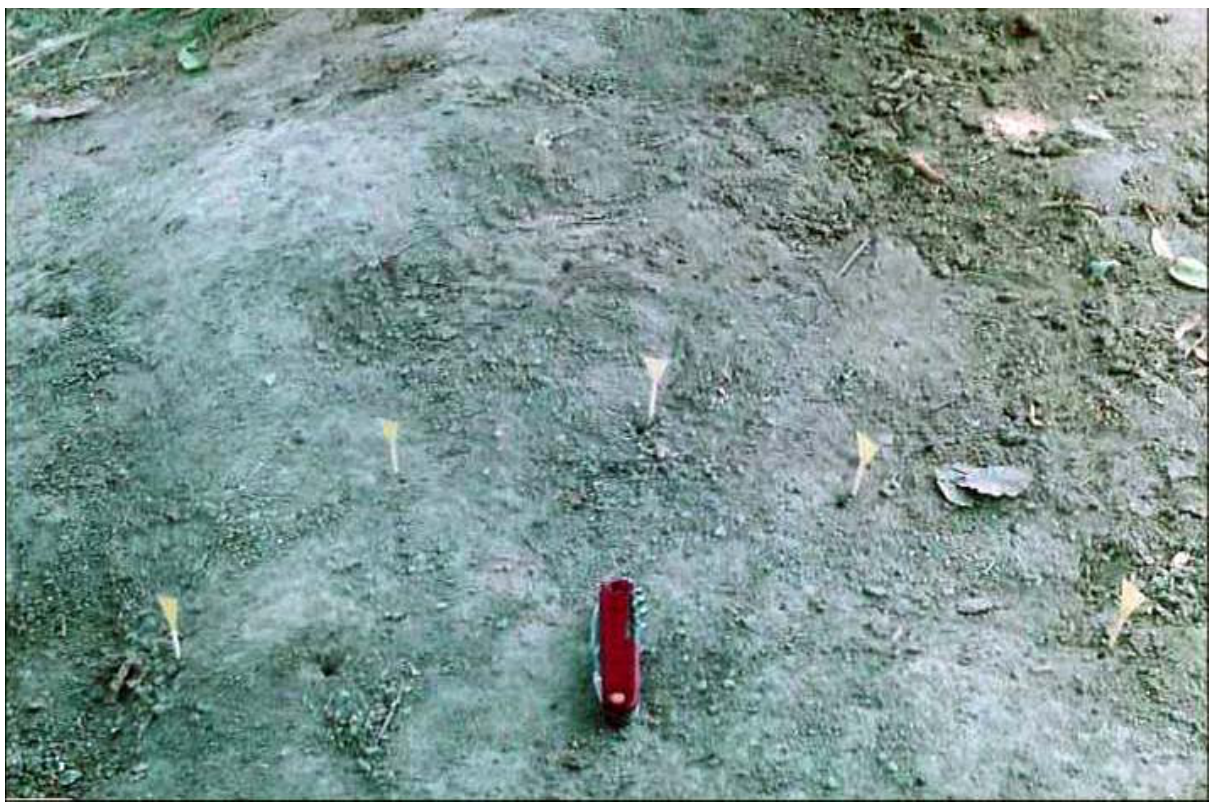
Figure 1. A marked colony of Pachycondyla sennaarensis in southeastern Iran. The small openings of the colony on the ground are indicated by triangular